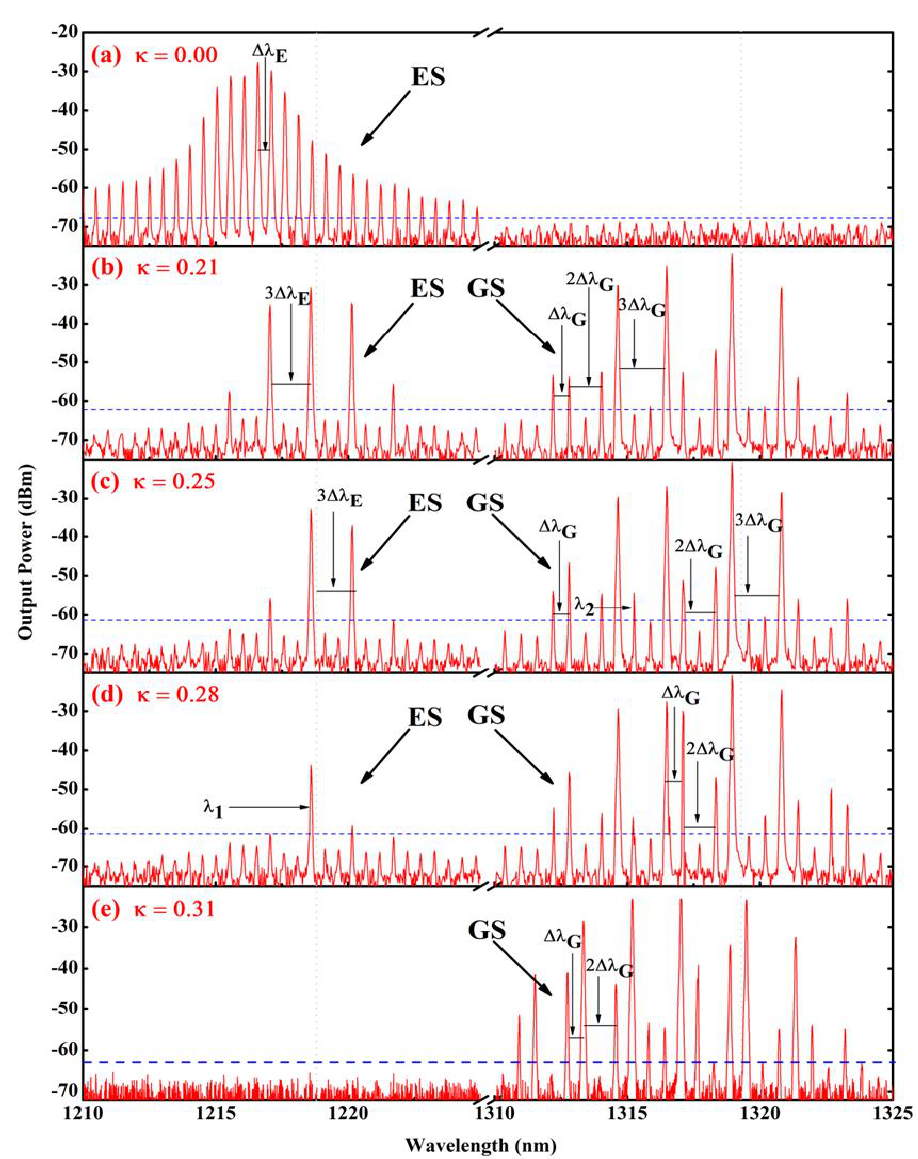
Figure 4. Optical spectra of the ESQDL under the biased current of 80.00 mA, where the longitudinal mode switching from the ES emission to the GS emission could be observed by varying the magnitude of the feedback ratio ( a – e ).